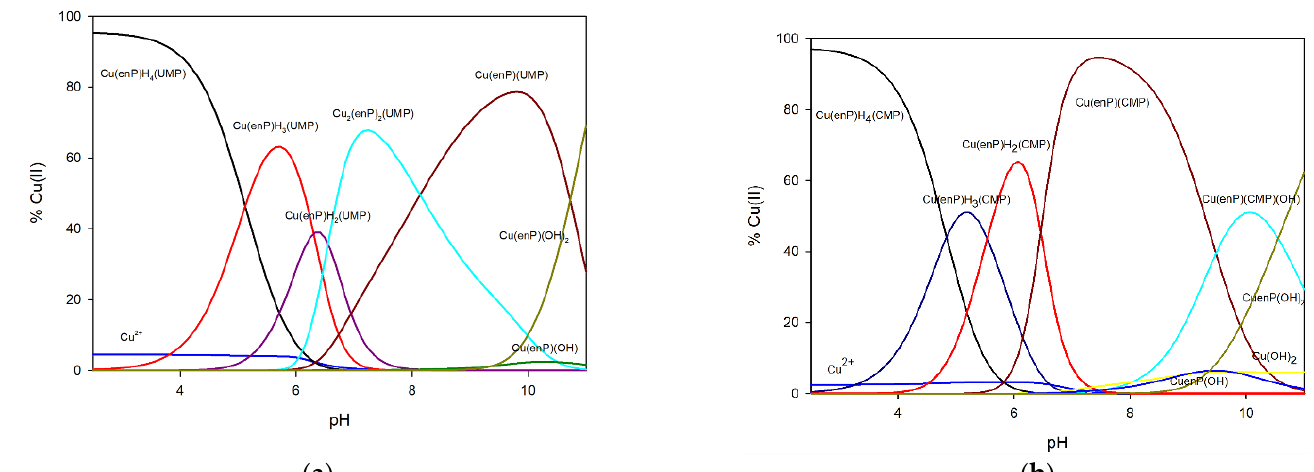
Figure 3. Distribution diagrams for ( a ) Cu(II)/enP/UMP and ( b ) Cu/enP/CMP systems.